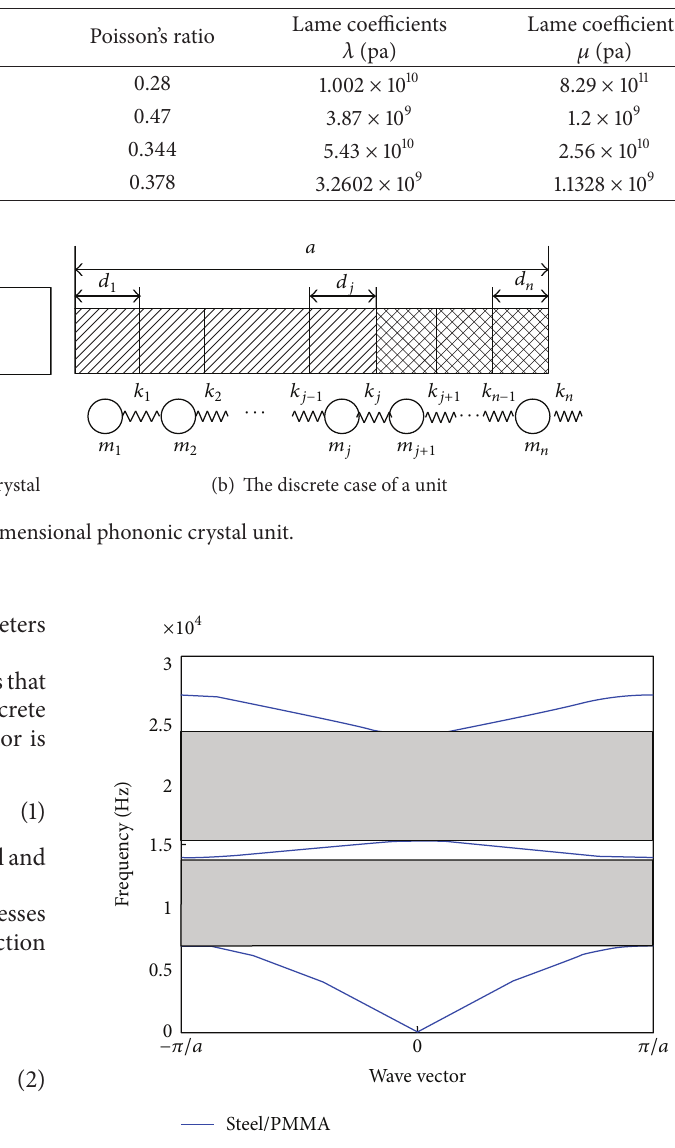
Table 2: Performance parameters of materials.